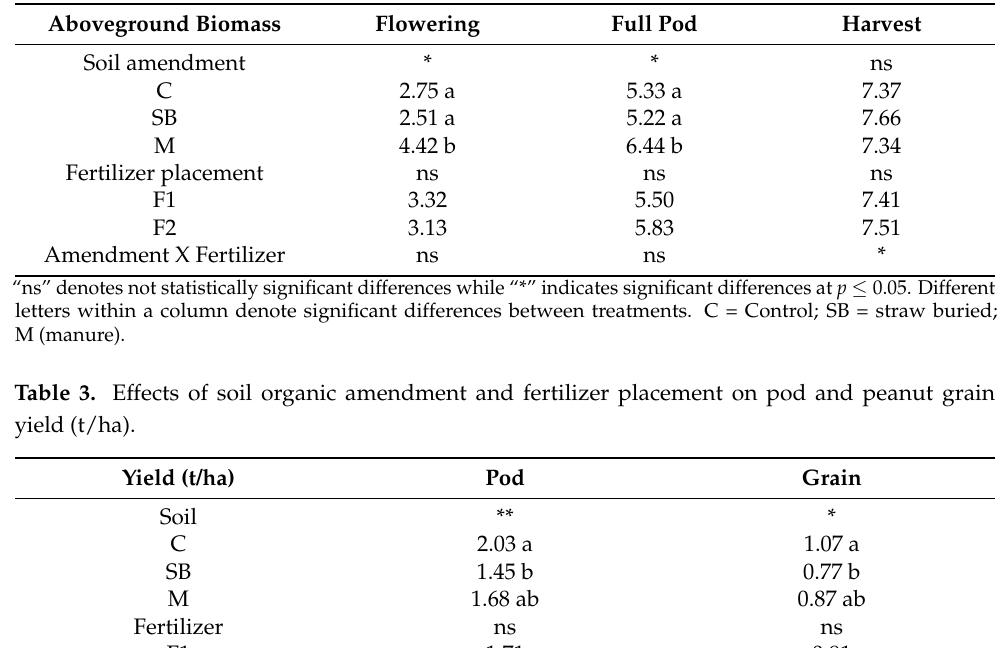
Figure 5. Average percentage of ground canopy cover of plants from the ( a ) soil amendment treatments: (no amendment (C), rice straw banded (SB) and manure (M)), and ( b ) fertilizer treatments tested in experiment 1 during the 2016/17 growing season. Different letters within a measurement date indicate statistically significant differences ( p < 0.05) between treatments. “ns” denotes not statistically significant differences. The order of the letters from top to bottom correspond with the order in which treatments are presented in the legend of each graph. Table 2. Two-way ANOVA for the effects of soil amendments and fertilizer placement on above- ground biomass of peanut (t ha −1 ) in experiment 1.